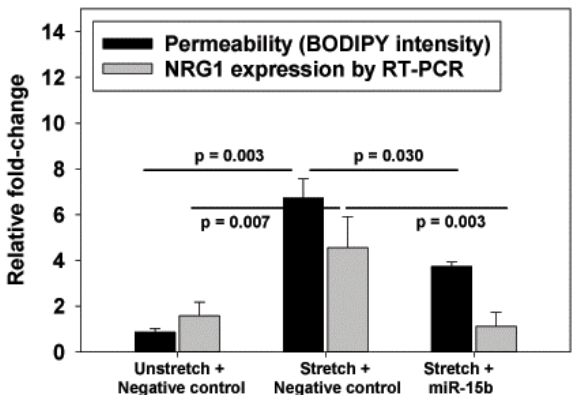
Figure 4. Effect of exogenous treatment with miR-15b (80 nM) or scrambled negative control on rat alveolar epithelial cells (RAEC) subject to cyclic stretch (ΔSA 25%, 0.25 Hz, 6 h). MiR-15b reduced stretch-induced increases in permeability and NRG1 mRNA levels. Values are normalized to unstretched cells. n = 5; p values represent the result of ANOVA and post-hoc Tukey (performed separately for permeability and NRG1 mRNA levels).